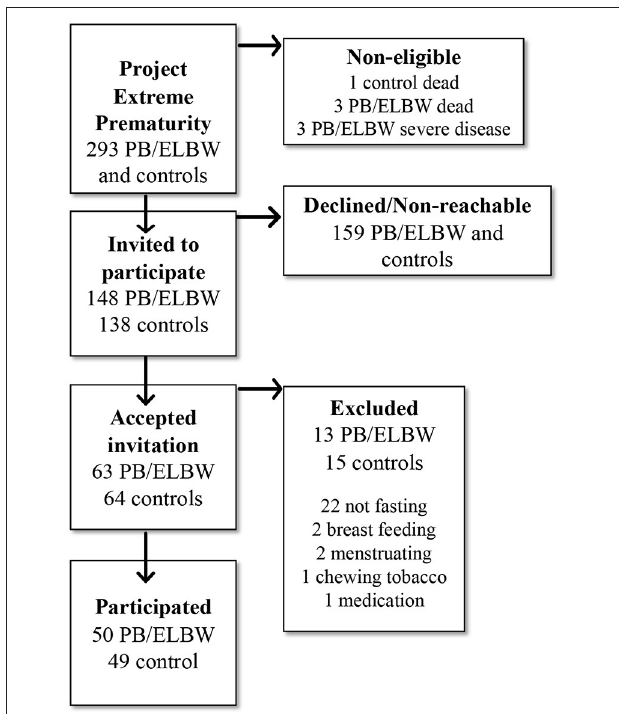
FIGURE 1 | Flow chart of the study population in the study of vascular endothelial function in young adults born very preterm or with extremely low birthweight (PB/ELBW) and term-born controls, part of the Project Extreme Prematurity in